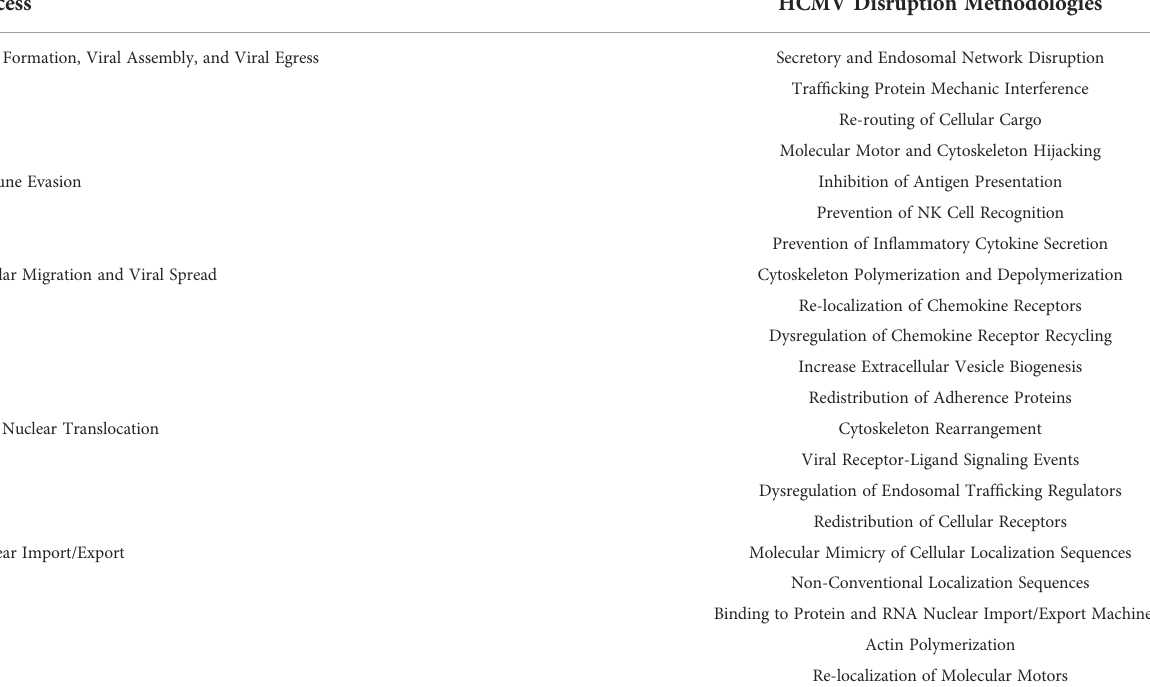
TABLE 1 Overview of HCMV-Induced Intracellular Traf fi cking Network Changes. Overview of the various methodologies by which HCMV manipulates intracellular traf fi cking networks to promote productive infection as discussed throughout the review.